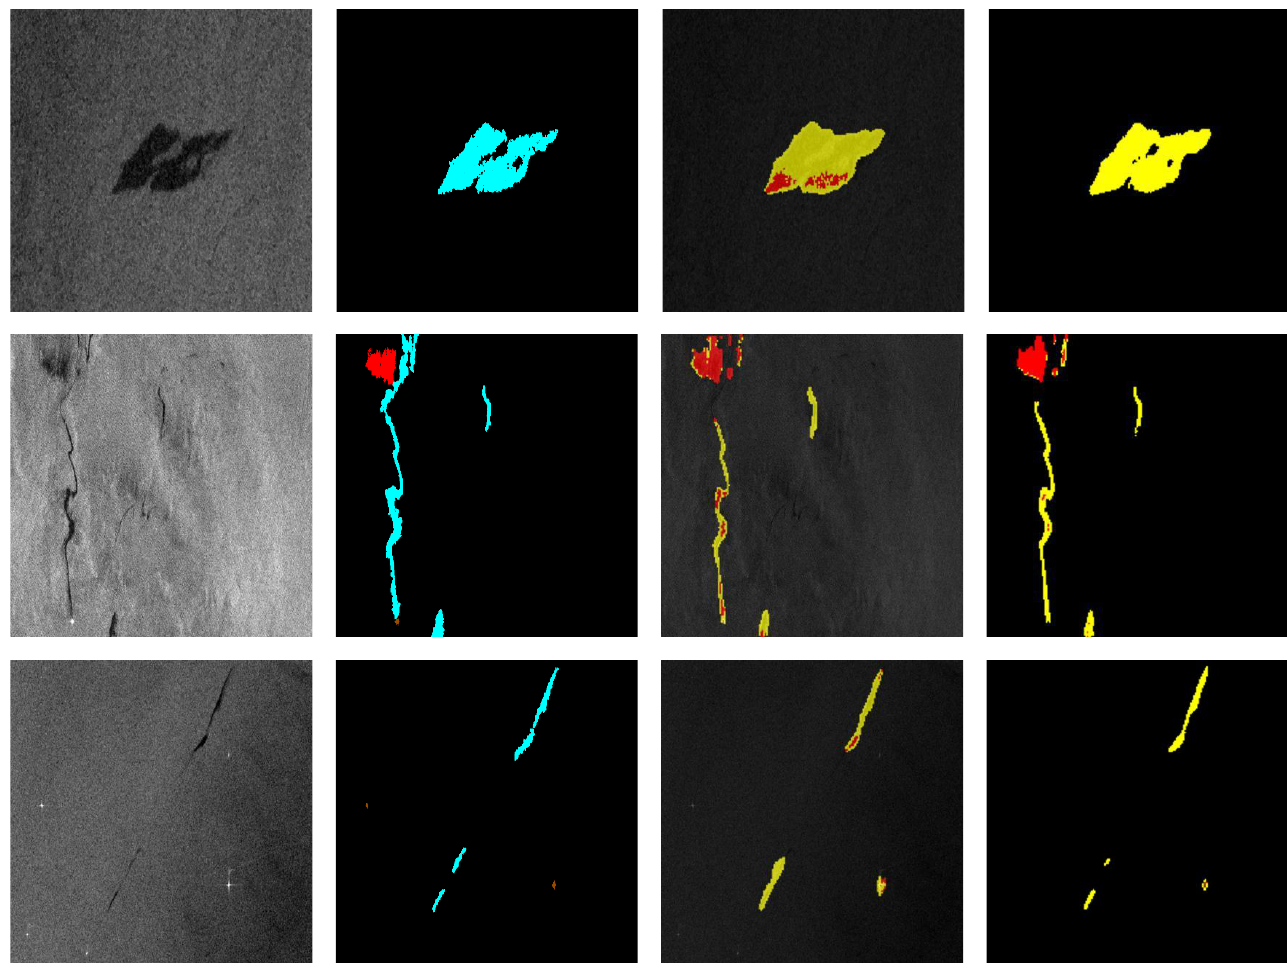
Figure 10. Curve of accuracy and error during validation iteration.